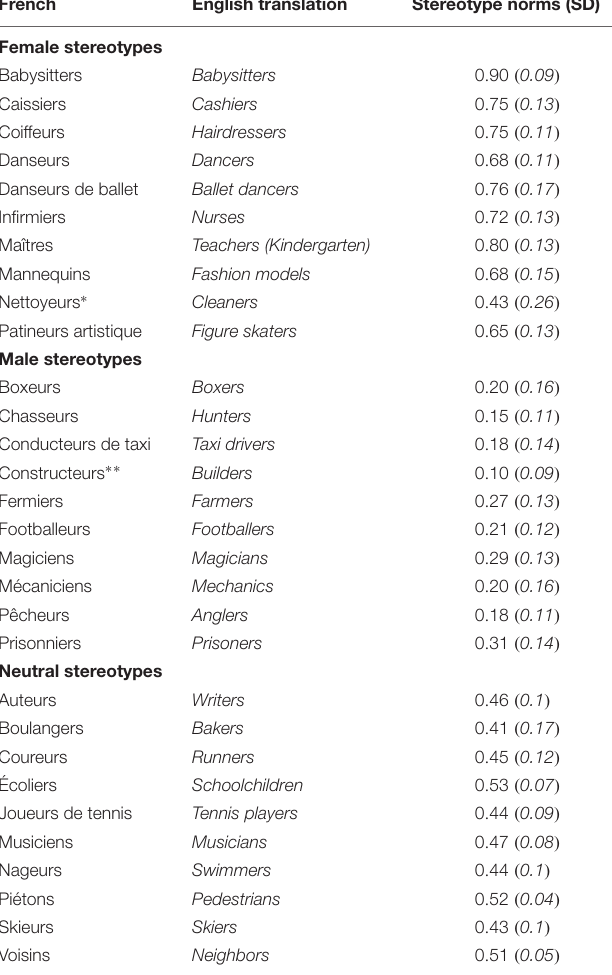
TABLE 1 | The list of French role nouns used in the experiment. French